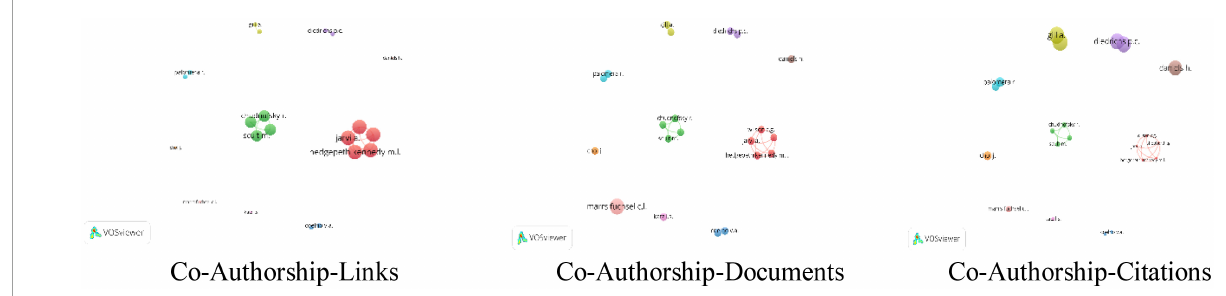
FIGURE8 Co-authorship and the contribution of authors.